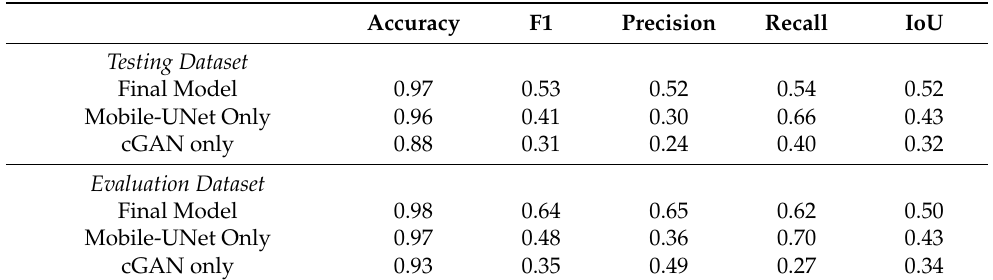
Table 1. Performance of different model components in building footprint detection, based on the testing and the evaluation sets, respectively.